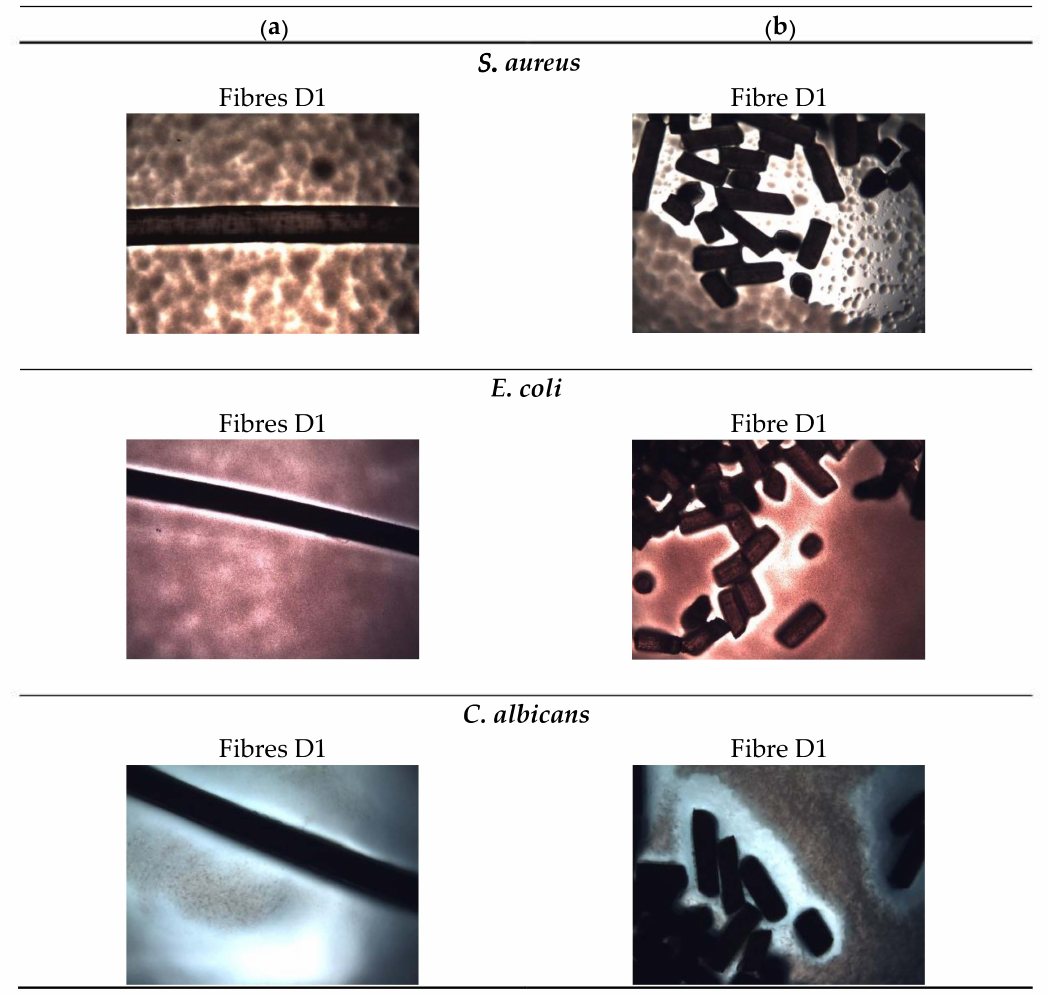
Figure 6. Photographs of microbiological tests of fibres with the highest amount of GO (D1). The photos show the tests for samples of: ( a ) Whole fibres; ( b ) fibre sections. The photos were taken after 24 h of S. aureus , E. coli , and C. albicans